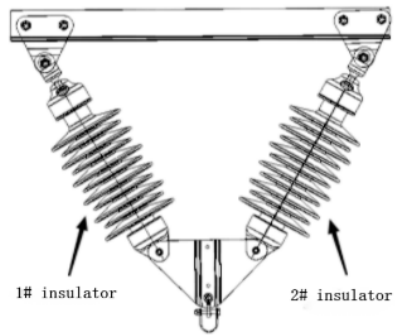
Figure 2. Diagram of two numbered